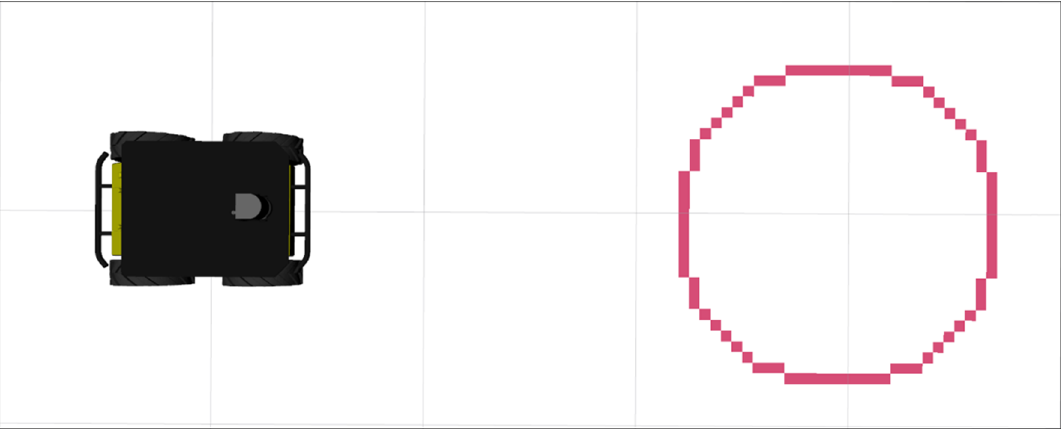
Figure 11. Behavioral costmap created by the Avoid-Leader-Zone perceptual schema behavior.